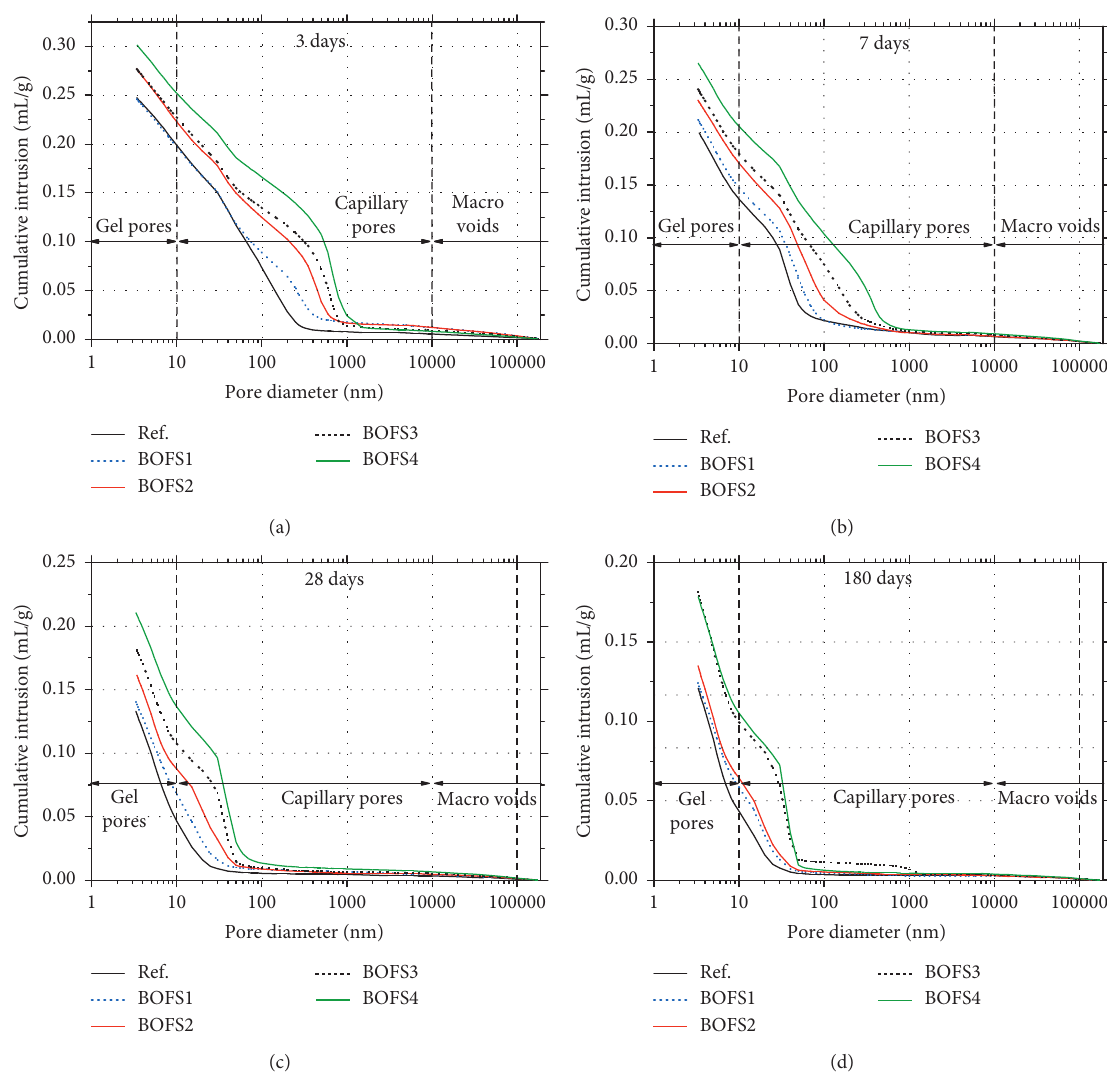
Figure 4: Cumulative PSD curves of cement pastes with BOFS at different curing